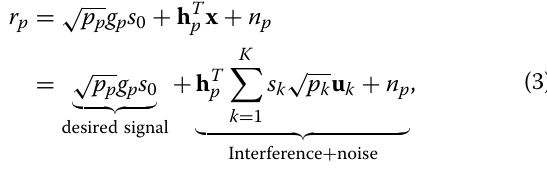
eters p p and s 0 denote the PBS transmission power and transmission data stream, respectively. Letting g k repre- sent the channel power gain vector from PBS to the SU k , the right-hand side of (2) can be decomposed into three terms: the first term is the desired signal from CBS to the SU k , whereas the second and third terms denote the inter- ference plus noise from the PBS and noise,